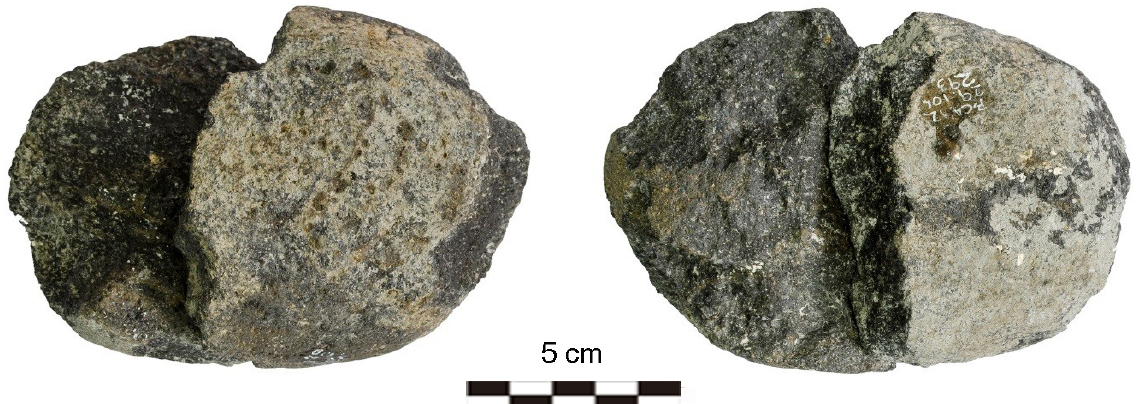
Figure 9. Hammer for reducing the rotary quern cylindrical blank. Cave 36, Cardones workshop. The scale bar is 5 cm (1 cm intervals).